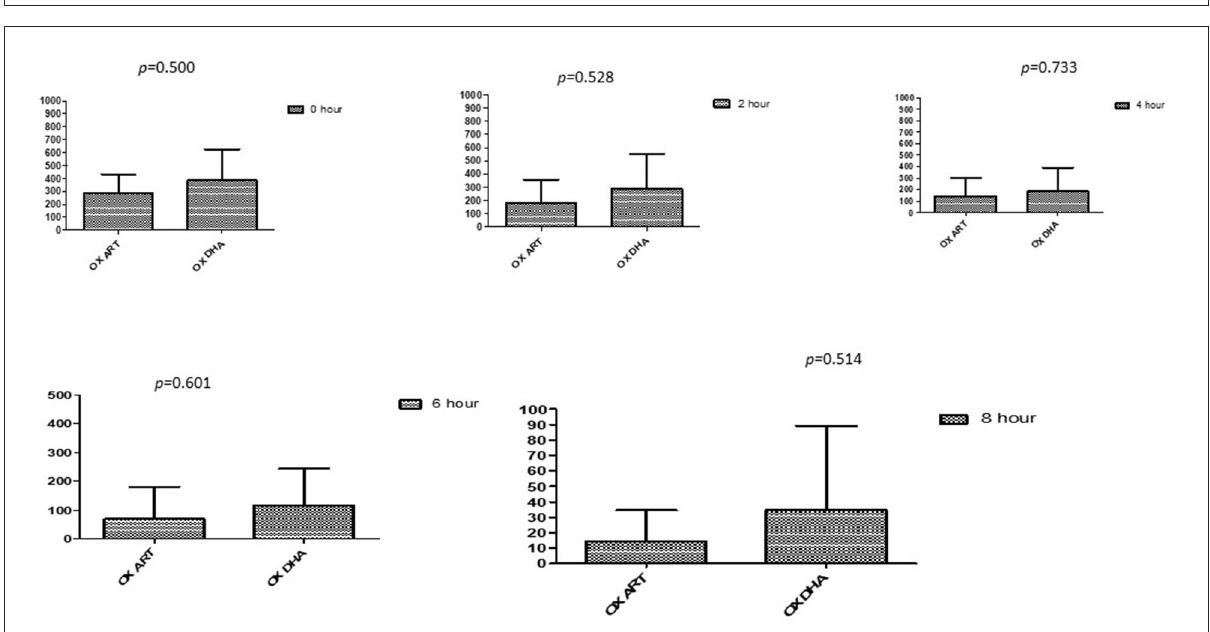
FIGURE4 Comparison of Oxacillin’s minimum inhibitory concentrations ( µ g/mL) when combined with ART and DHA on E. coli. OX ART, Oxacillin combined with ART; OX DHA, Oxacillin combined with DHA; p < 0.05 indicate a significant difference among MICs of antibiotic combined ART and